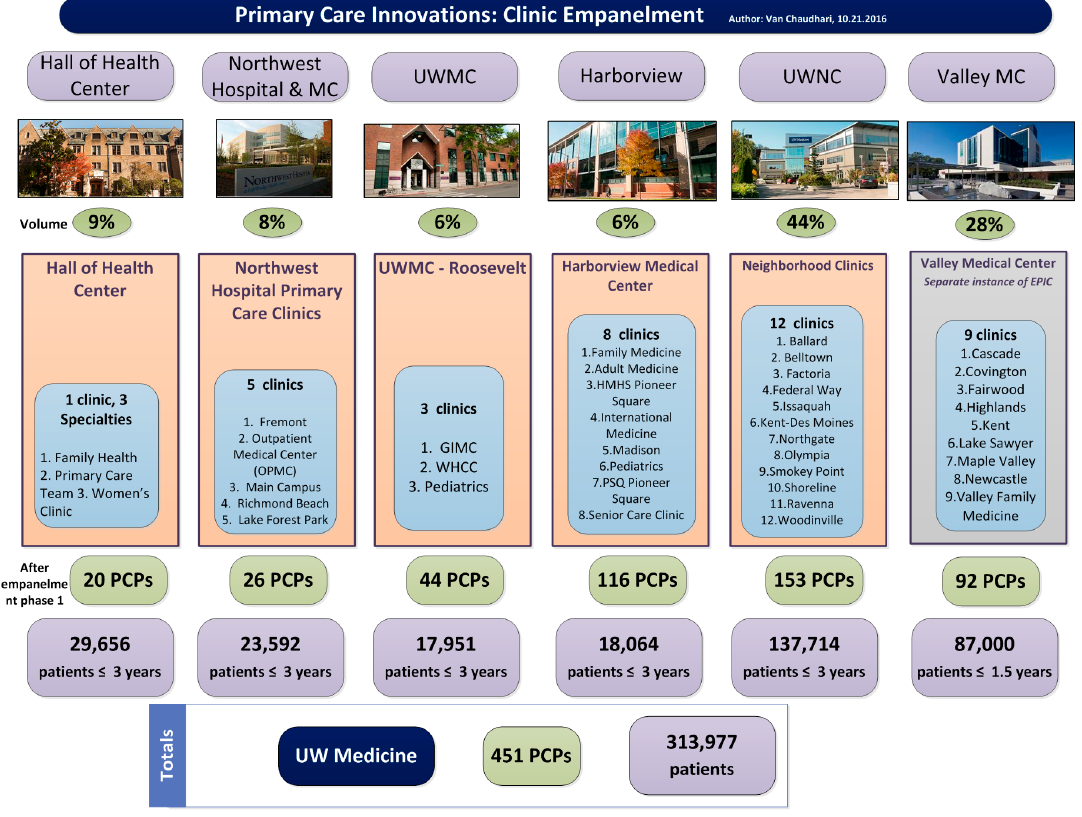
Figure 1. An overview of empanelment at University of Washington Medicine outlining the number of primary care providers (PCPs) at each entity, including UW Neighborhood Clinics (UWNC) & UW Medical Center ambulatory clinics